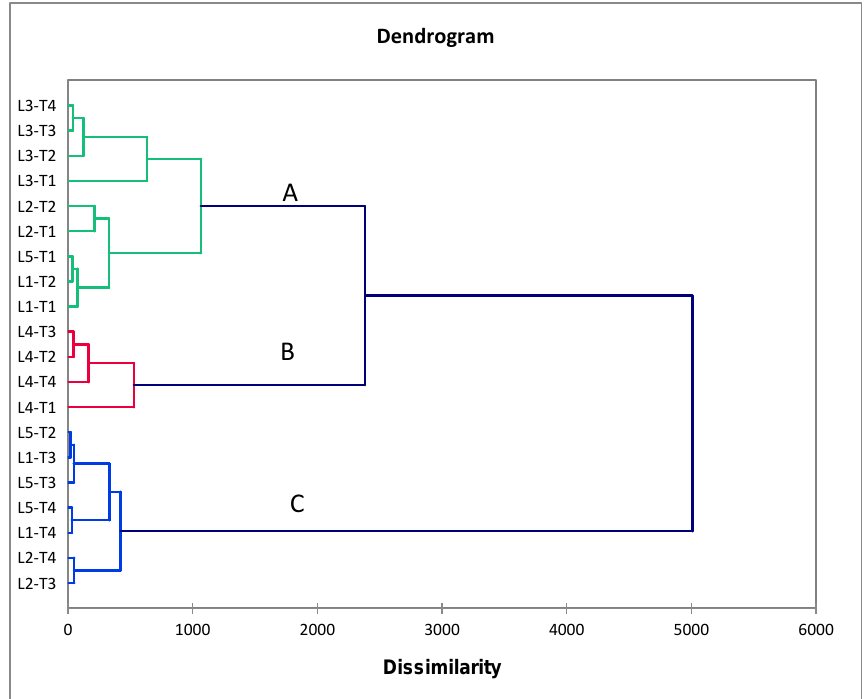
Figure 4. Agglomerative hierarchical clustering (AHC) based on the measured floral, growth, and yield traits divided the tested treatments into three main clusters.